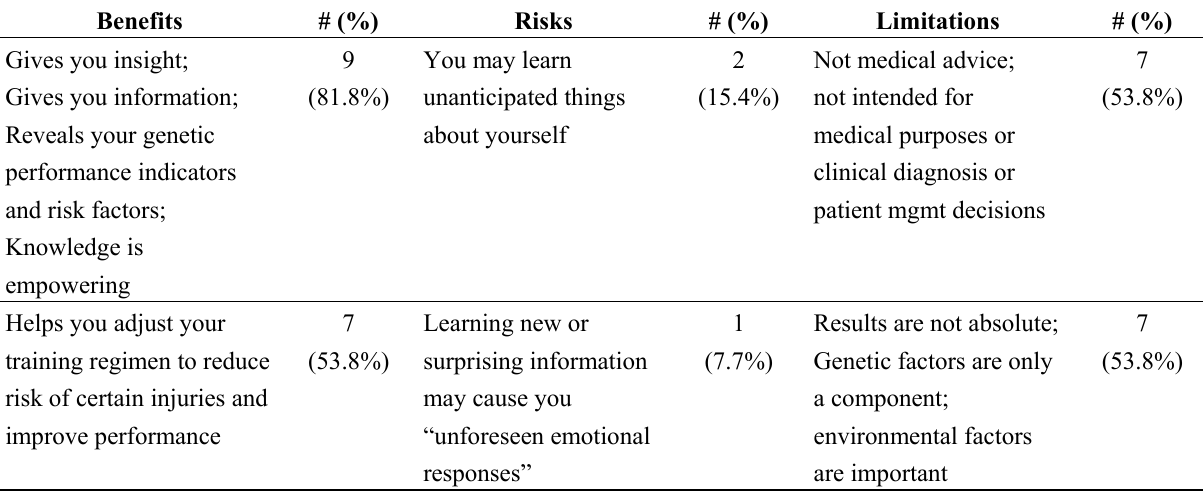
Table 5. Stated benefits, risks, and limitations of sports-related genetic